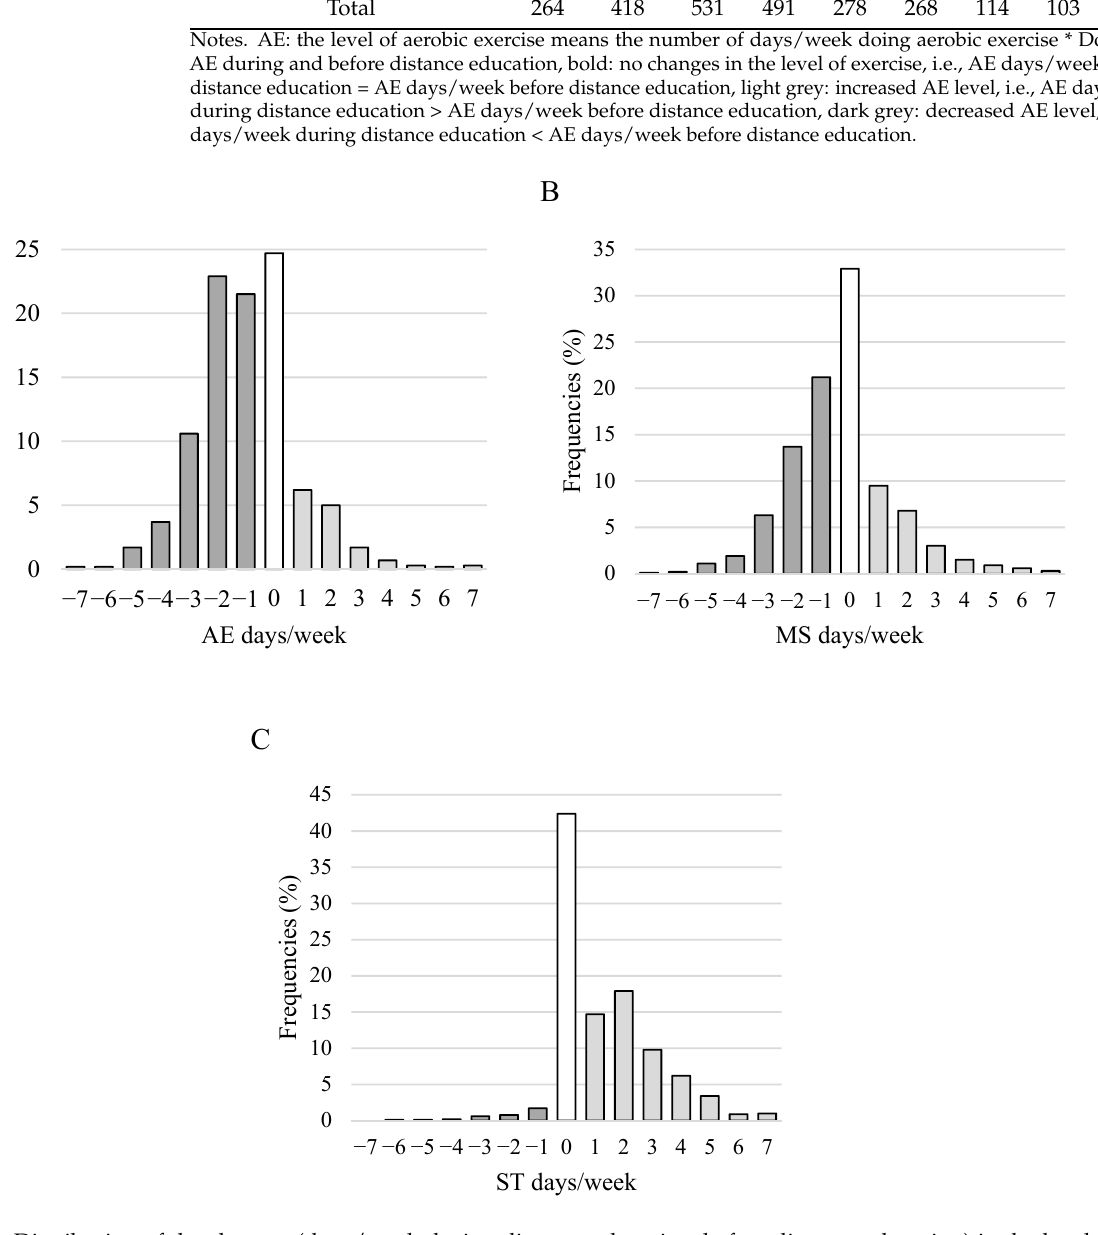
Table 2. Shift table for the level of aerobic exercise before and during distance education. AE Days/Week during Distance Education 0 1